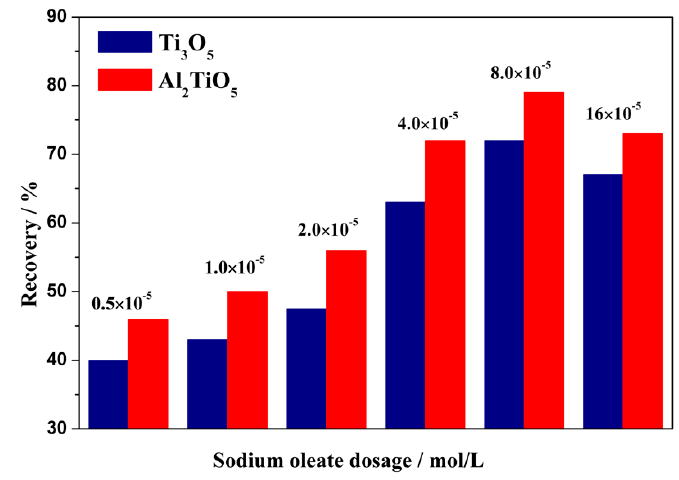
Figure 6. Dosage e ff ect of sodium oleate on flotability of Ti 3 O 5 and Al 2 TiO 5 crystals (pH = Figure 6. Dosage effect of sodium oleate on flotability of Ti 3 O 5 and Al 2 TiO 5 crystals (pH = 6).